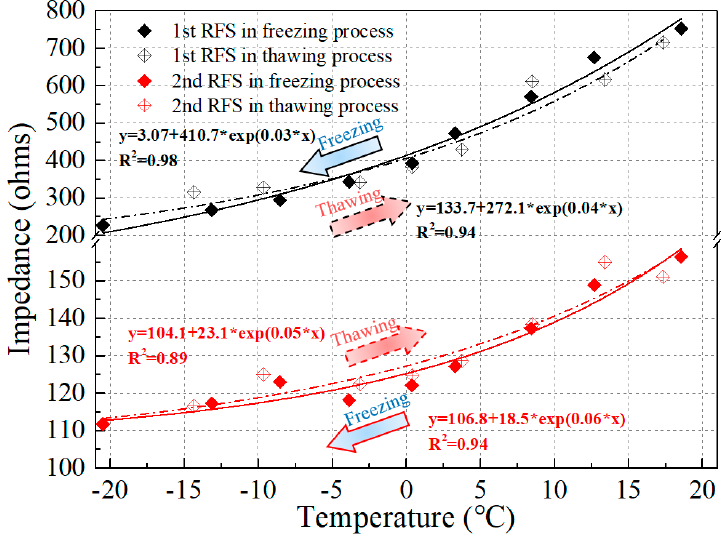
Figure 8. Variation of impedance at resonant frequencies with temperature.